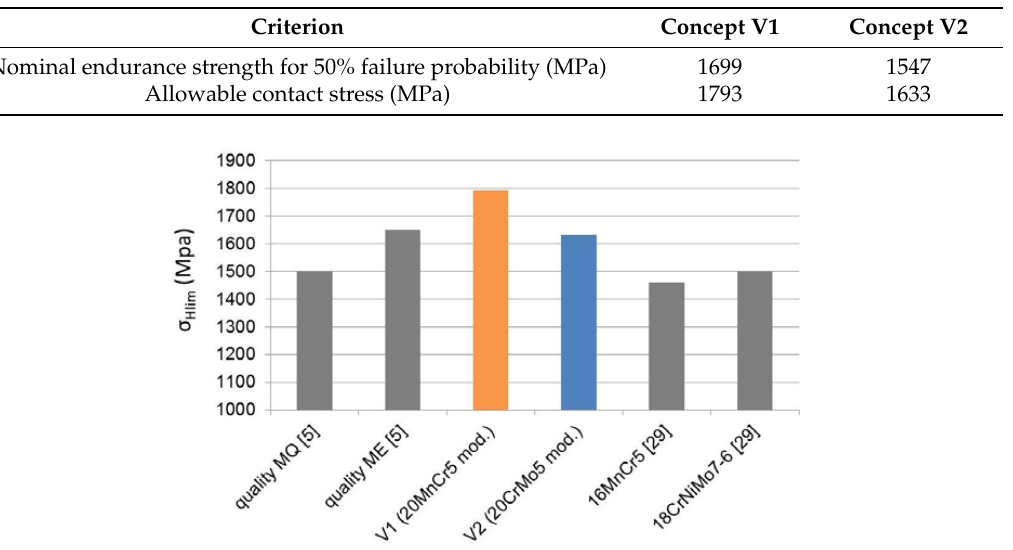
Table 6. Experimentally-determined endurance limit for pitting.